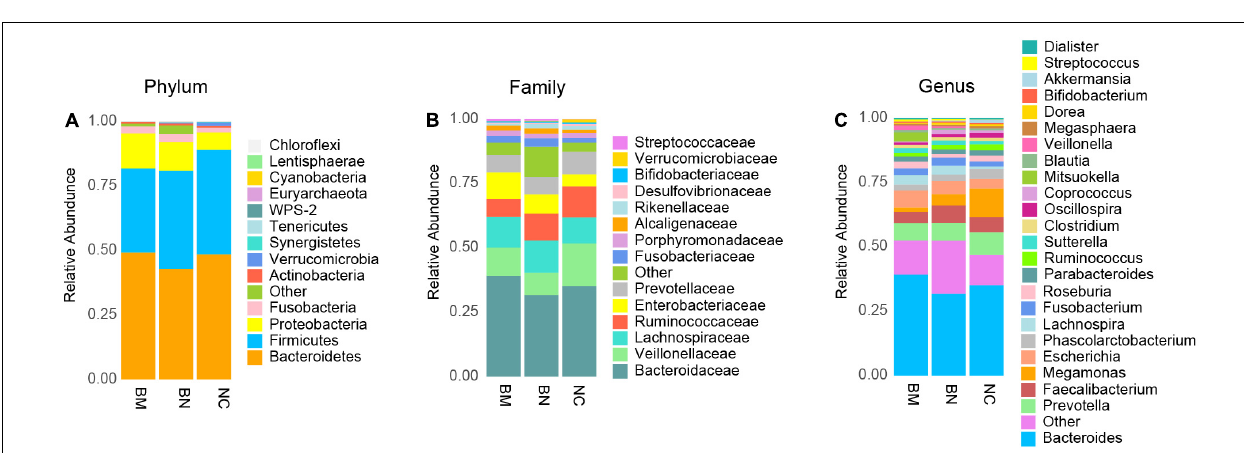
FIGURE 3 | Compositional analysis of the gut microbiota community. (A) Compositional analysis of the gut microbiota community in NCs, BNs and BMs at the phylum level. (B) Compositional analysis of the gut microbiota community in NCs, BNs, and BMs at the family level. (C) Compositional analysis of the gut microbiota community in NCs, BNs, and BMs at the genus